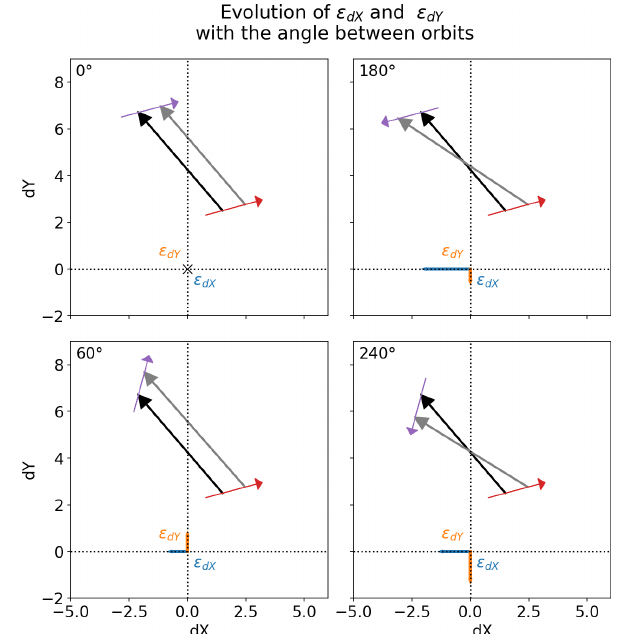
Figure 8. Impact of a constant geolocation error in the flight direc- tion on S2S retrievals. Each panel corresponds to a different relative angle θ r between the two orbits from which sea-ice drift vectors are estimated. The true drift vector is in black, and the geolocation off- sets in the first and second orbits are of the same length and create an erroneous drift vector (grey). The errors in the dX and dY com- ponents are ε d X and ε d Y